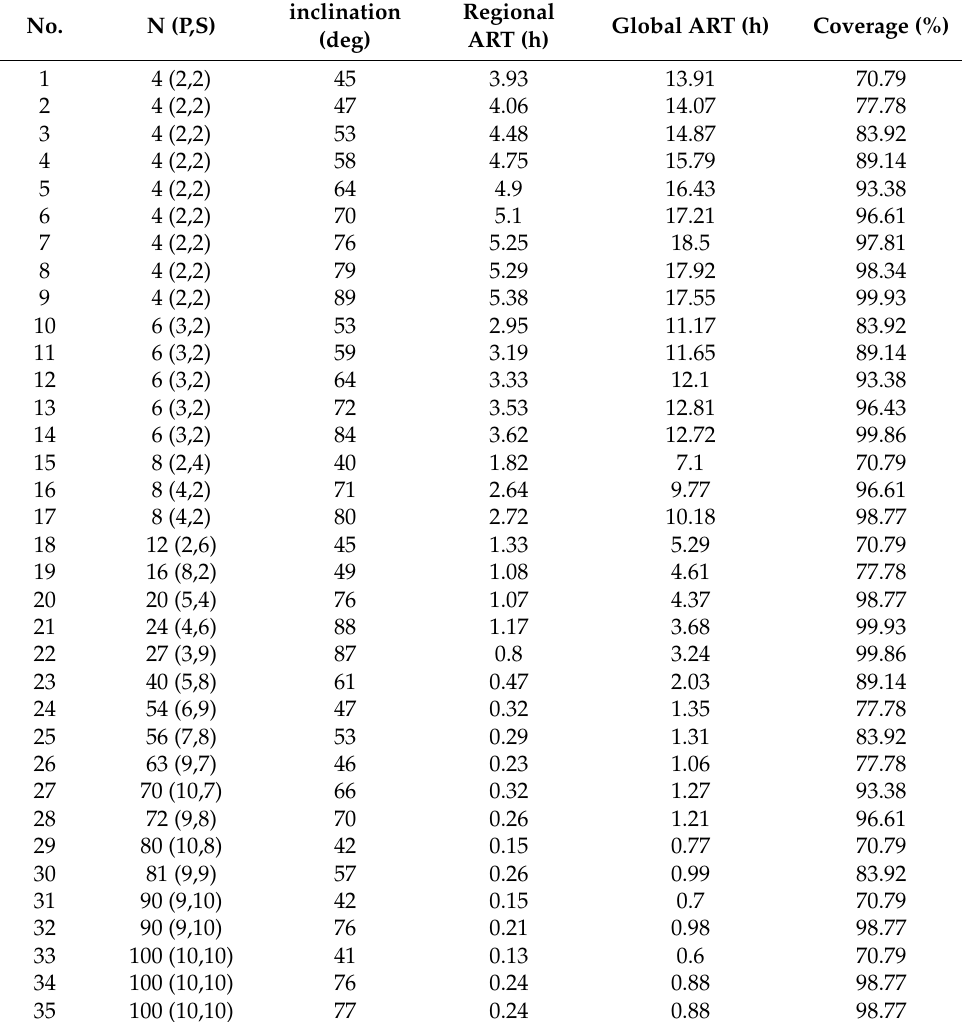
Table 3. Pareto front solution for multi-mission